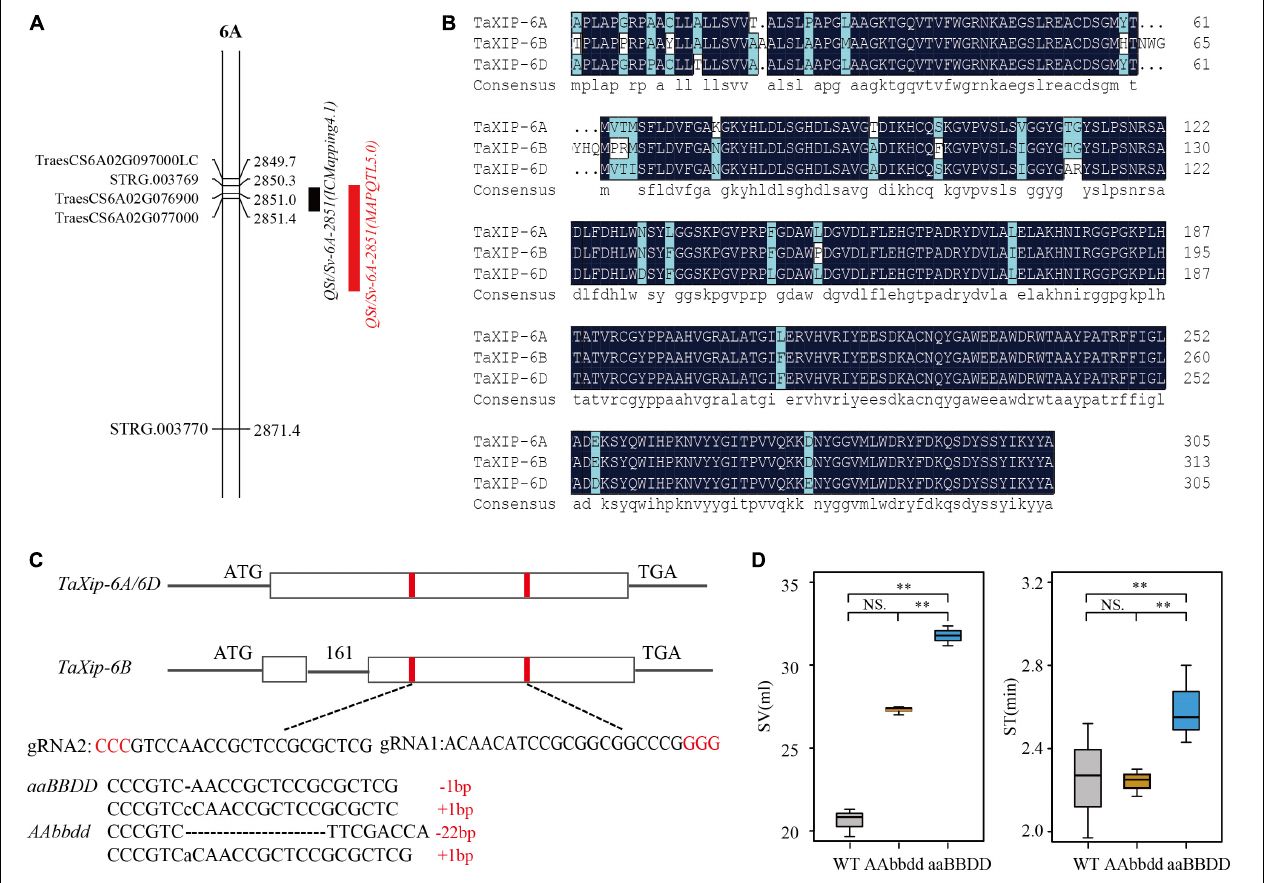
FIGURE 1 | Mapping of QSt/Sv-6A-2851 and development of TaXIP mutants by CRISPR/Cas9-mediated genome editing. (A) QTL mapping for QSt/Sv-6A-2851 using IciMapping 4.1 (black bar), MapQTL5.0 (red bar) software. (B) Amino acid sequence alignment for three homologous genes TaXip-6A , TaXip-6B, and TaXip-6D in “Fielder.” (C) Schematic map of the sgRNAs target site selection in the TaXip genes and the T 2 : 3 mutant types ( aaBBDD and AAbbdd ) induced by CRISPR/Cas9. The vertical bar is exon and the horizontal line is intron, the protospacer-adjacent motif (PAM) is highlighted in red. (D) Difference for SV and ST between T 2 : 3 mutant lines and WT (Fielder). “**”represents extremely significant